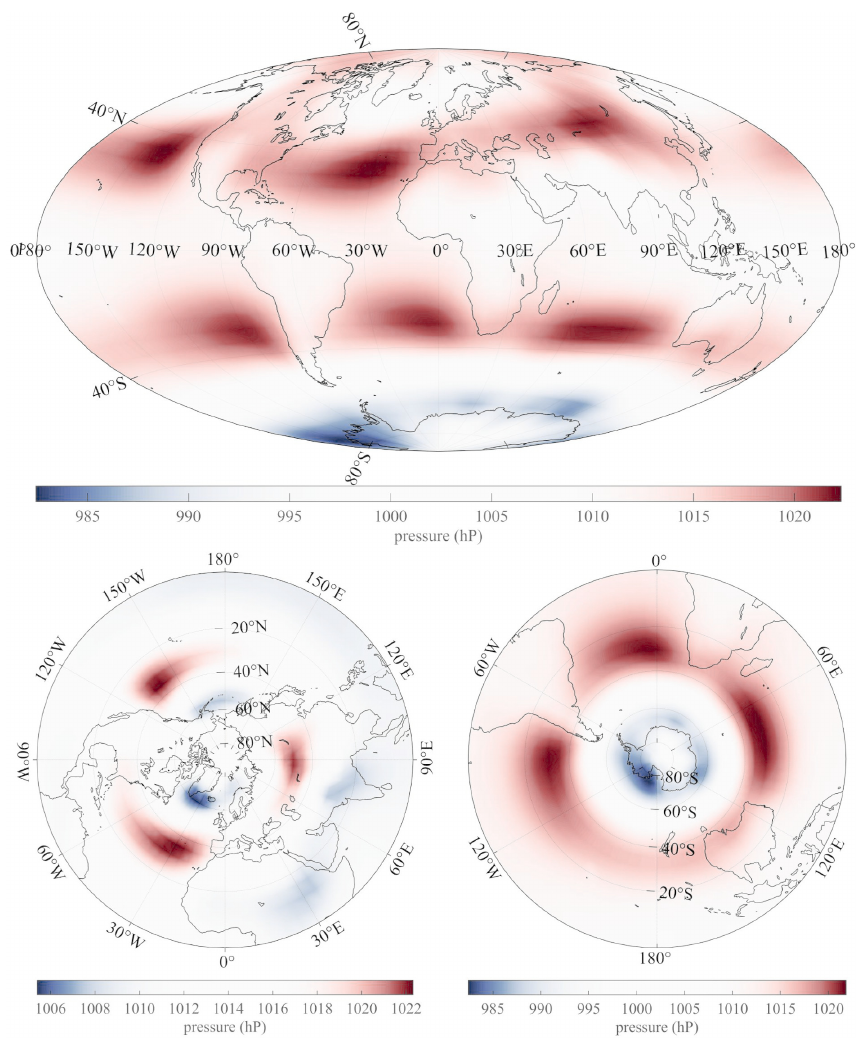
Figure 3. Mean of trends of pressure at sea level from 1850 to 2020 ( SLP ), determined using singular spectrum analysis ( SSA ) (top: Hammer–Aitoff projection; lower left: stereographic projection of the NH ; lower right: stereographic projection of the SH ).